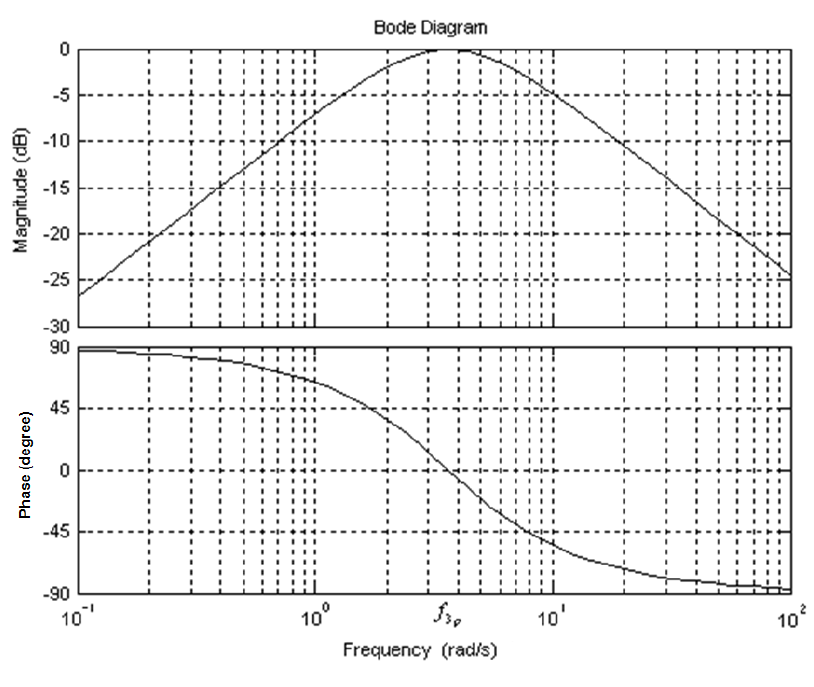
Figure 6. Bode plot of the designed BP